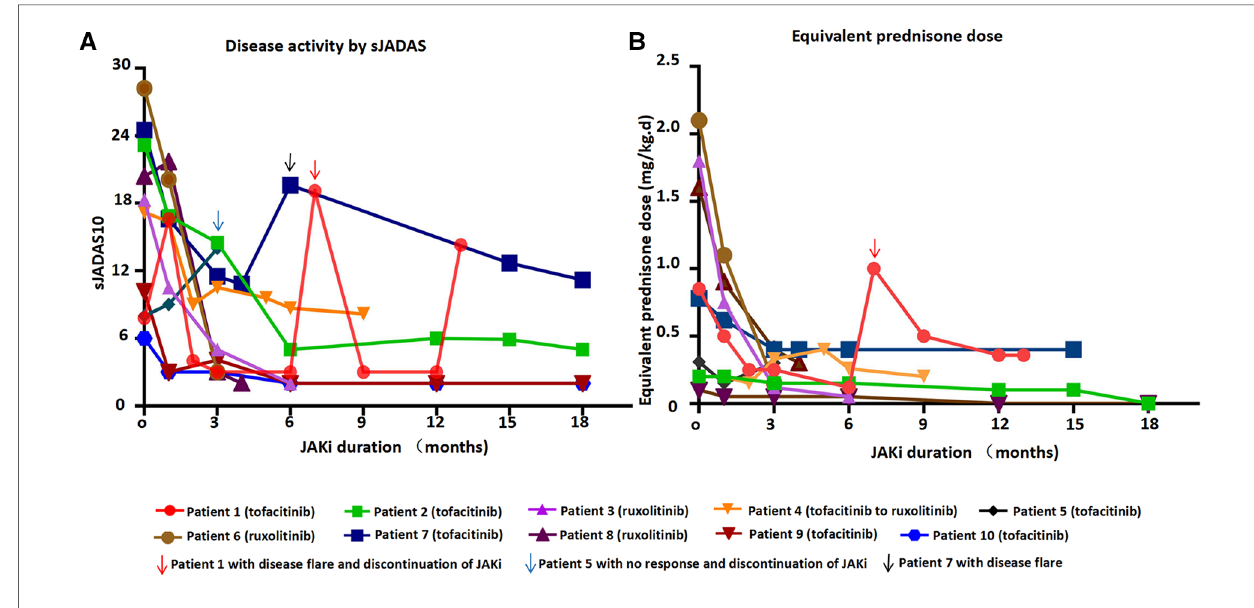
FIGURE 1 Disease activity by sJADAS and equivalent prednisone dose over time at JAKi